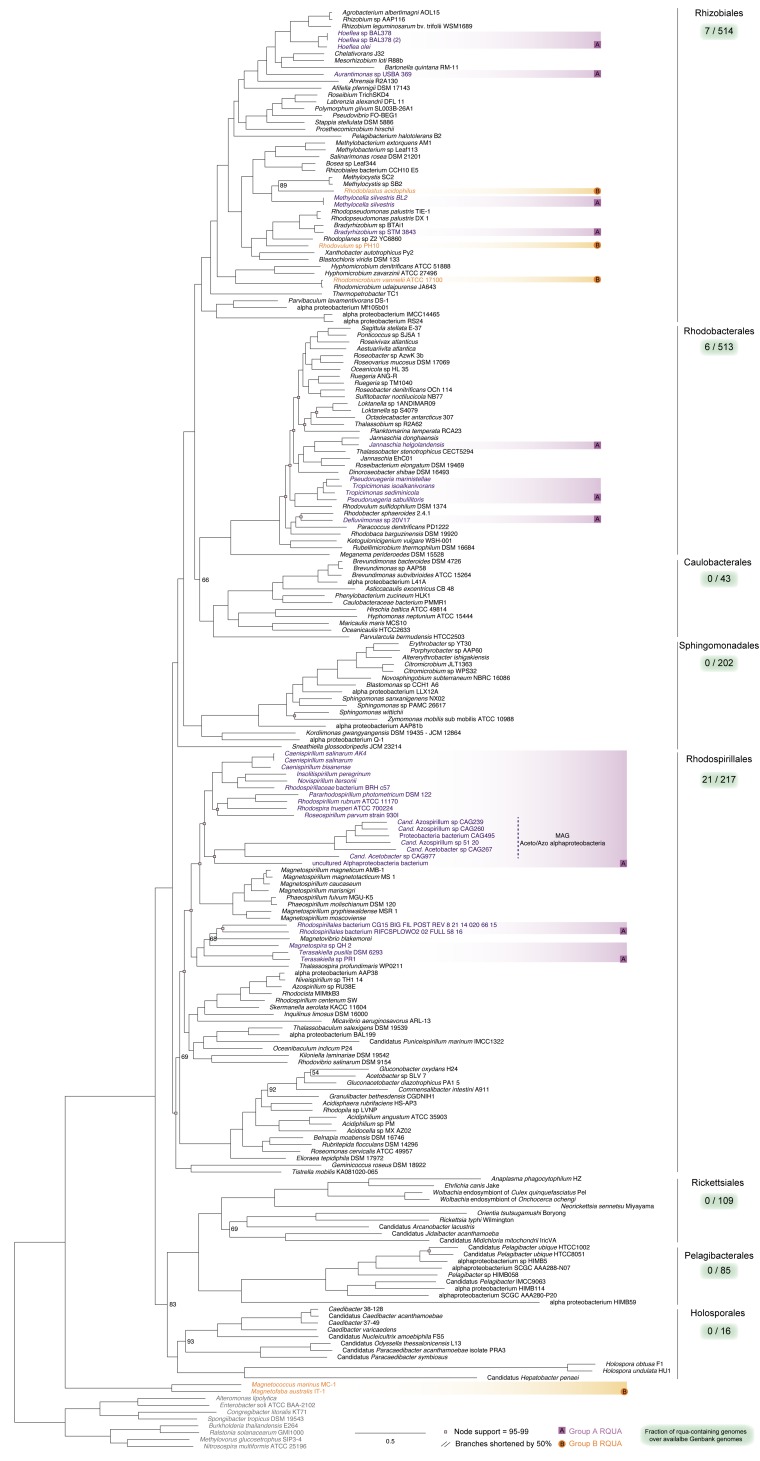
Intron positions in eukaryotic rquA gene sequences.Nucleotide from both transcriptome and genomic sequencing projects (when available) were aligned using Sequencher (Gene Codes v 5.4.6) and introns were manually inspected for position, length and phase. The phase indicates the position of the intron relative to the codon where phase 0, 1 and 2 begin before the codon, in between position 1 and 2, or in between position 2 and 3 respectively. All introns were major spliceosomal introns with GT-AG boundaries. In general, intron positions and lengths were not conserved in distantly related species.